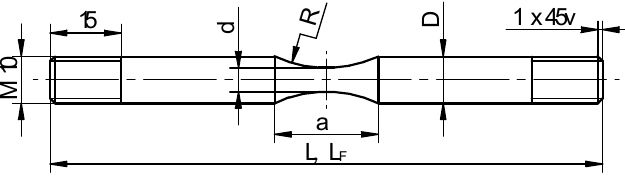
Figure 3. The shape of the tensile specimen and its basic dimensions expressed in mm.